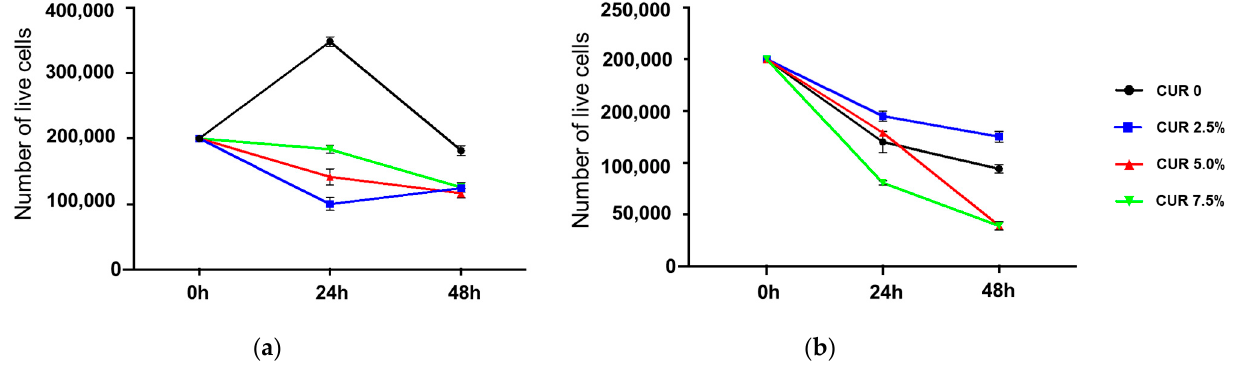
Figure 6. Cell viability profile of HBEpC 24 and 48 h after incubation with CUR-loaded ( a ) H ALG and ( b ) H ALG-GO . Data are expressed as means ± SD of three counts.